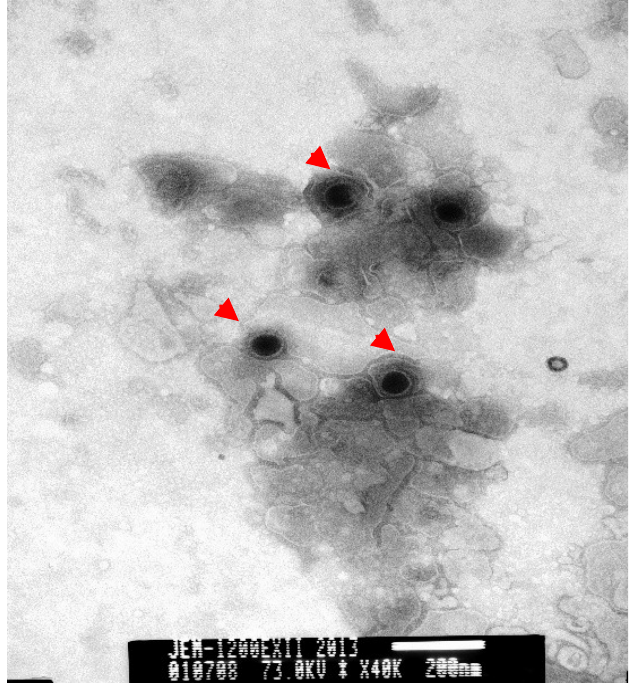
Figure 4. Negative-stained electron micrograph of FHV-1 particles. The electron micrograph of cell cultures (Magnification ×40,000) revealed circular or oval herpesvirus-like particles that appeared as spheres and ellipsoids with diameters ranging from 150 to 200 nm (as arrow indicated). Size bars indicate 200 nm.